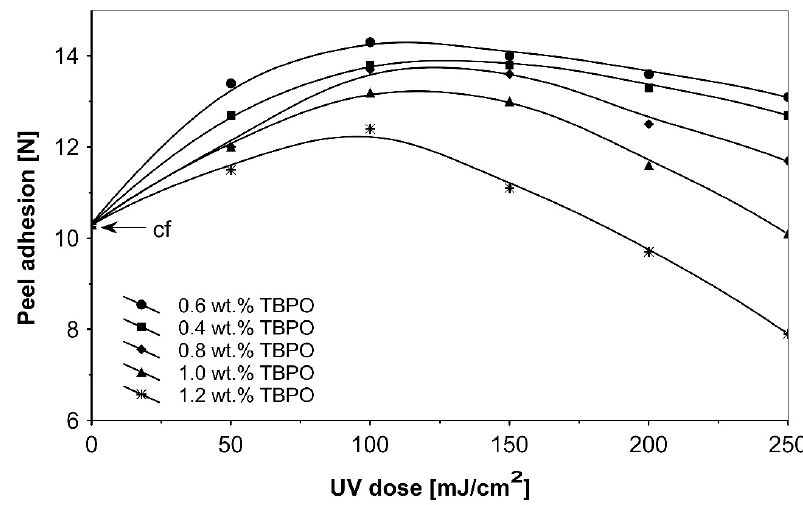
Figure 9. Peel adhesion versus UV dose for the use of tris ‐ benzophenyloxy phosphineoxide (TBPO).